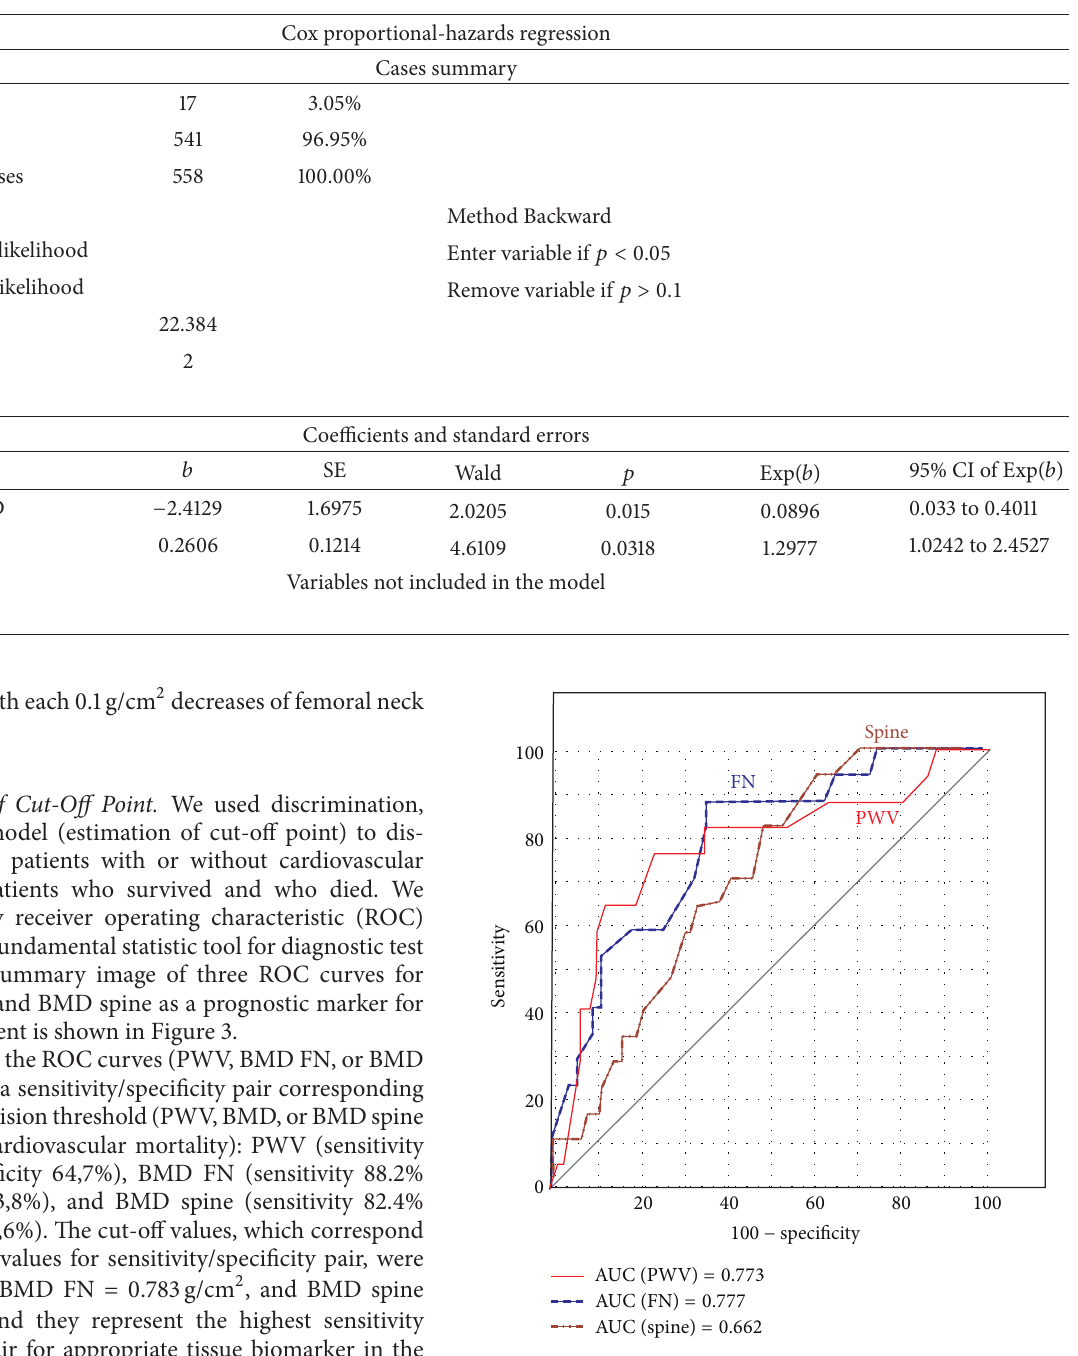
Table 4: Cox-regression survival analysis (predictors of cardiovascular outcome).